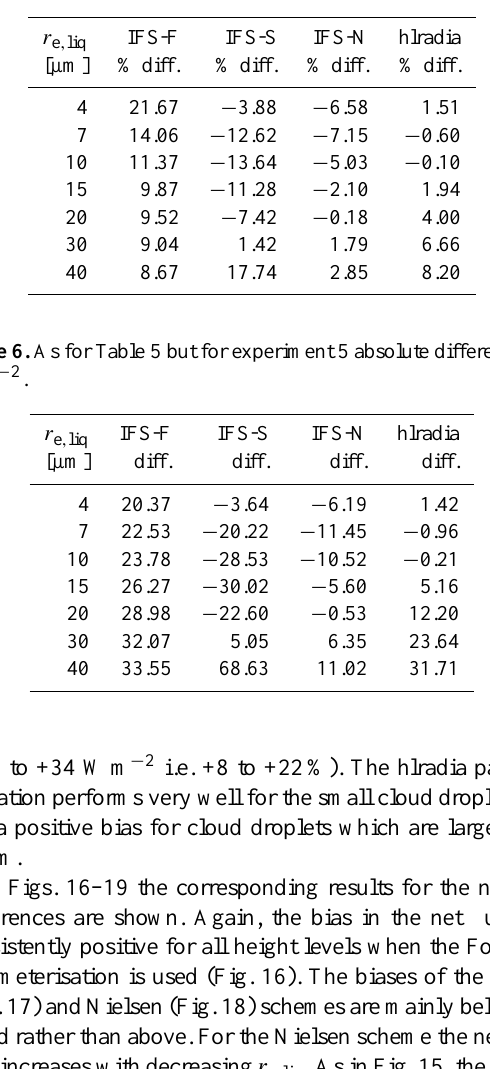
Table 5. Relative differences for experiment 5. IFS-F, IFS-S and IFS-N refer to the IFS radiation scheme using the Fouquart (1987), the Slingo (1989) and the Nielsen liquid cloud optical property pa- rameterisations, respectively.